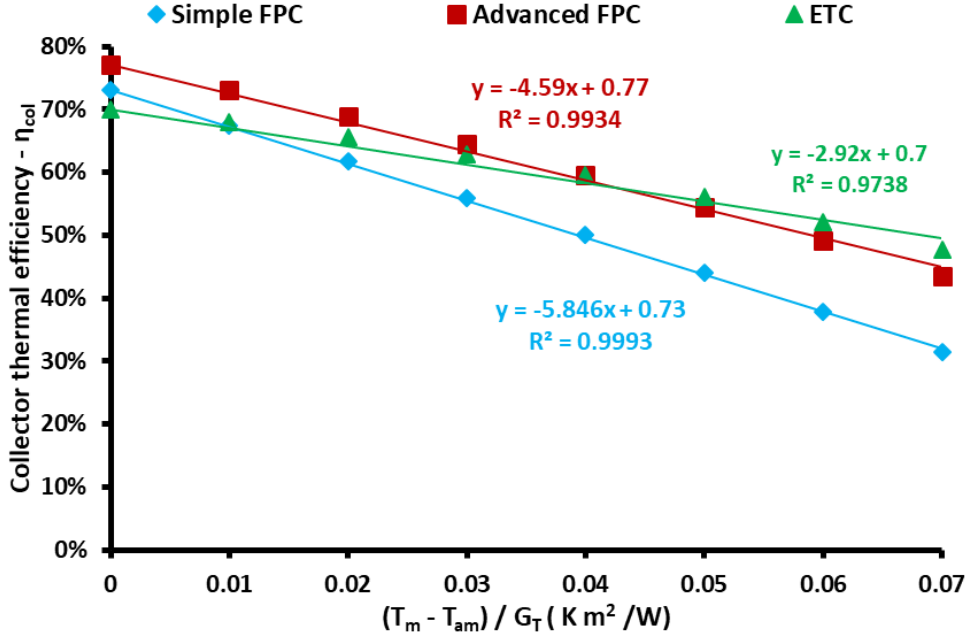
Table 2. Thermal efficiency parameters of the collectors after the approximation.